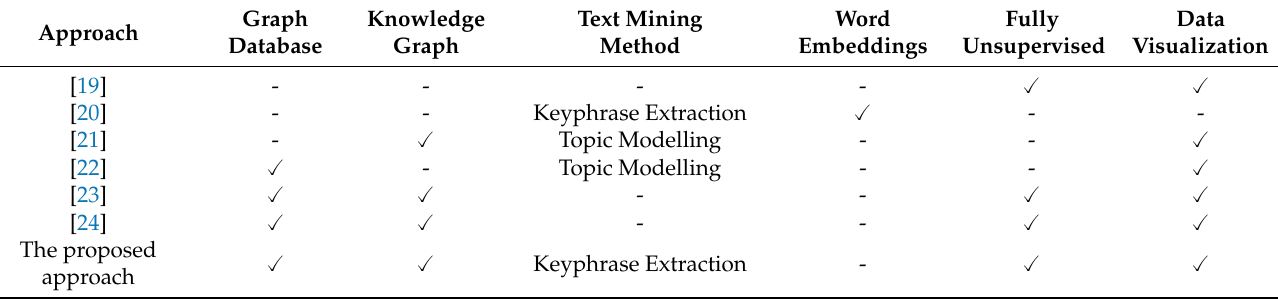
Table 1. Overview of key characteristics of various